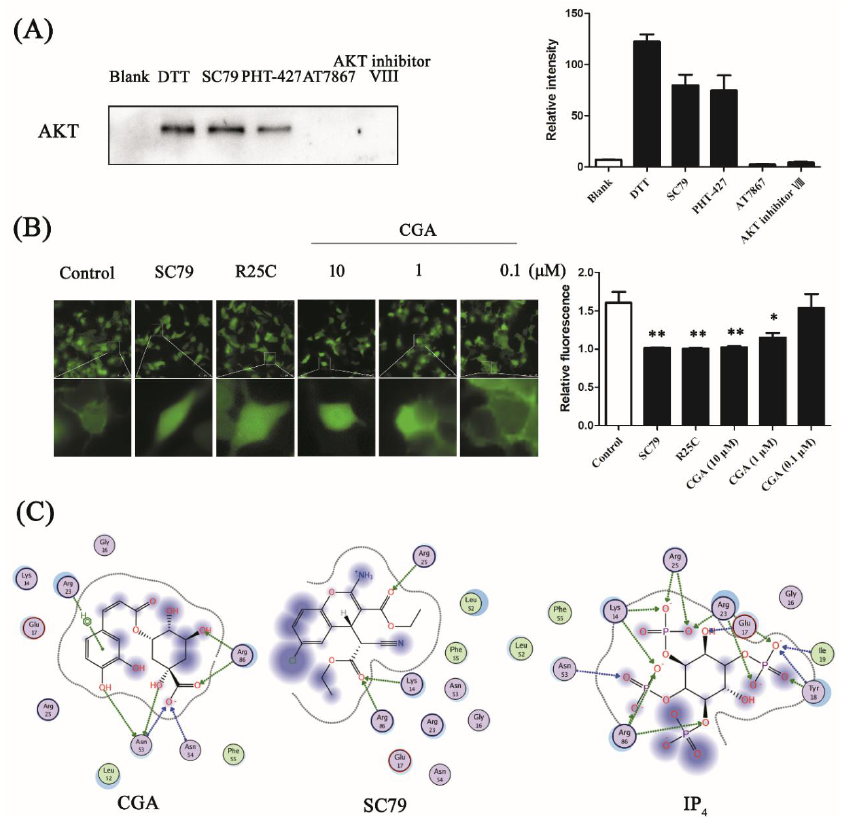
Figure 3. Confirmation of CGA binding to the AKT pleckstrin homology (PH) domain and the predicted interaction pose. ( A ) Competition tests of SC79, PHT-427, AT7867, and AKT inhibitor VIII with the CGA probe against enriched AKT by CGA-modified functionalized MMs. Bands of AKT were detected by Western blot. Blank: fished proteins by azide-modified MMs; DL-dithiothreitol (DTT): released proteins by DTT from CGA-modified functionalized MMs. SC79, PHT-427, AT7867, and AKT inhibitor VIII samples were replaced from CGA-modified functionalized MMs by treatment with SC79, PHT-427, AT7867, and AKT inhibitor VIII, respectively. The histogram presents the relative intensities of the AKT bands ( n = 3). ( B ) Representative images showing the membrane translocation of AKT PH with and without CGA treatment (upper row, 40 × ; lower row, 200 × ). The histogram presents the relative fluorescence of AKT-PH-GFP on the HEK 293T membrane. Each bar represents the mean ± SEM. * p < 0.05 vs. control; ** p < 0.01 vs. control ( n = 8 cells). ( C ) Two-dimensional interaction map for CGA, SC79, and inositol (1,3,4,5)-tetrakisphosphate (IP 4 ) docked with AKT PH-domain-binding sites, respectively (Protein Data Bank (PDB):